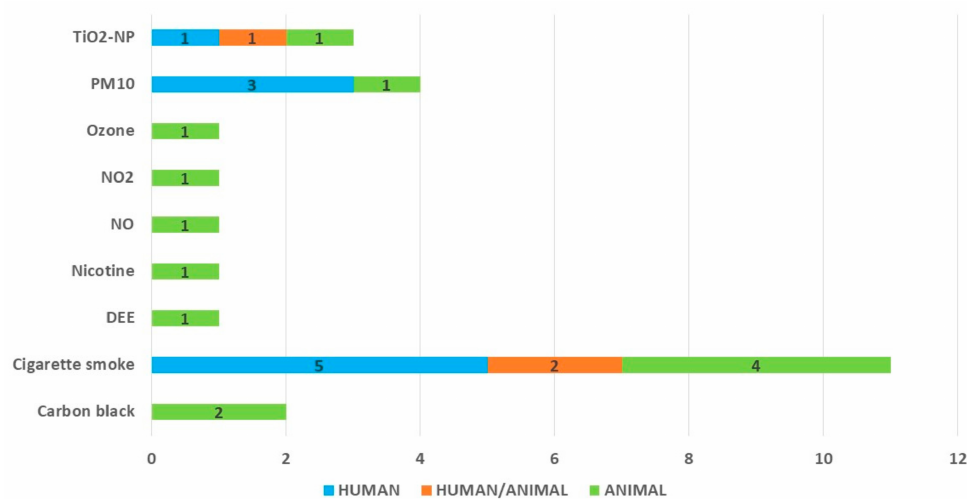
Figure 4. The number of studies investigating the particular air pollutants according to the model used in the study: blue—human model, orange—mixed human and animal model, green—animal model. TiO 2